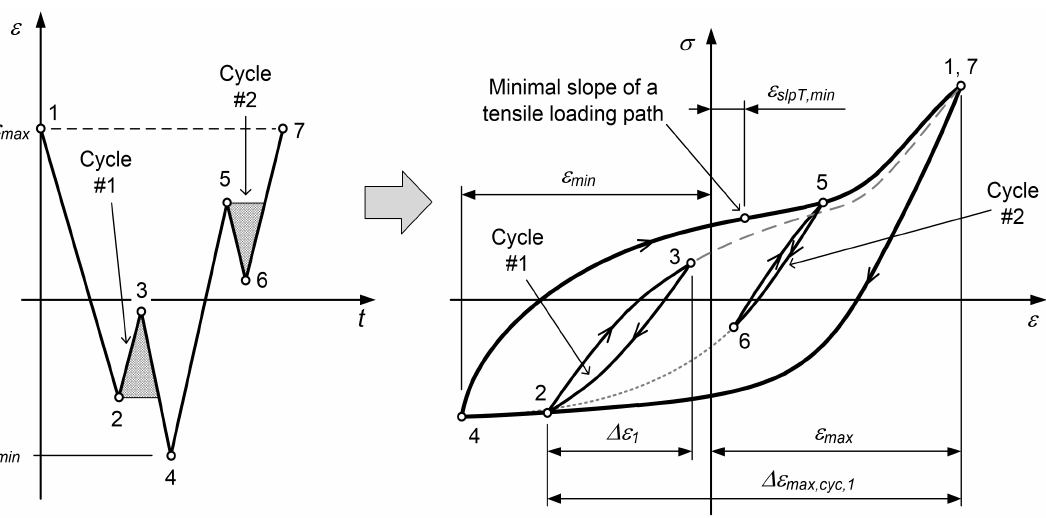
Figure 3. Modelling the loading paths and loading cycles on the basis of the ε ( t ) time